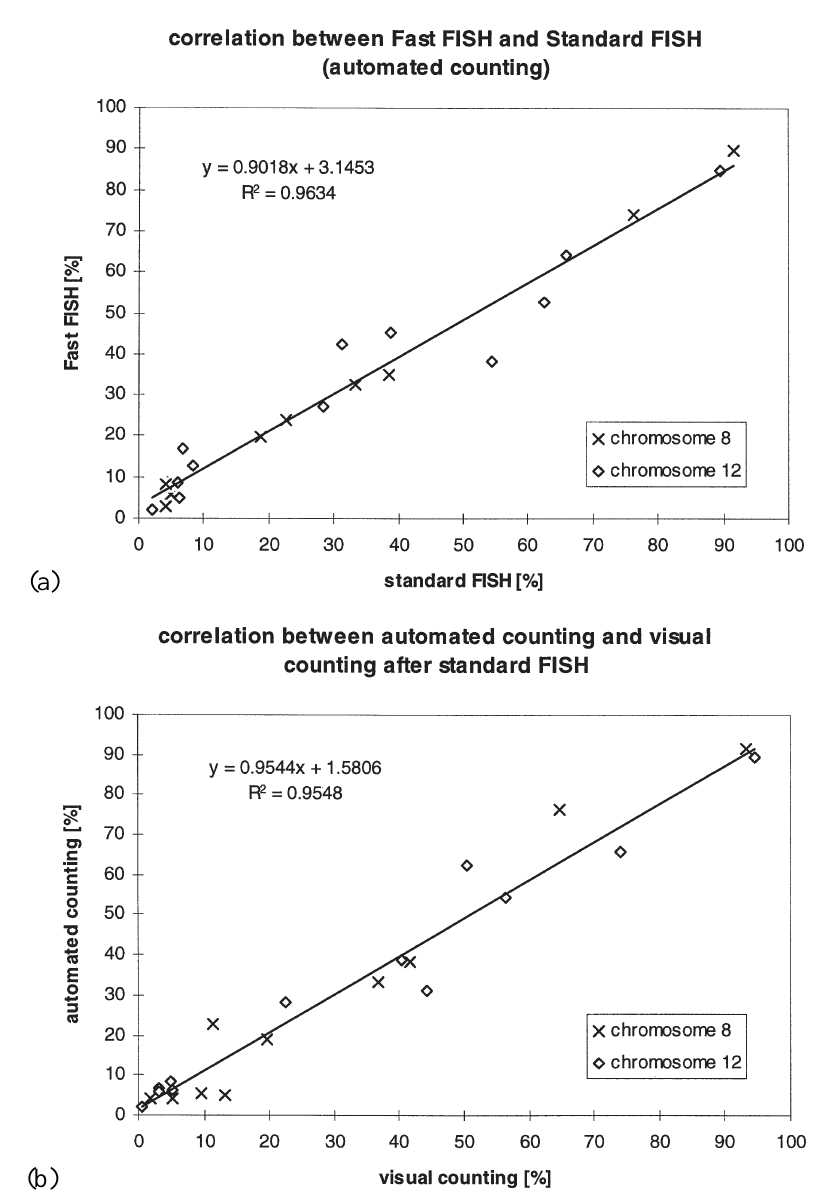
Fig. 4. Correlation of the percentage frequencies from Table 1. (a) Correlation of the values of column C to the values of column B. (b) Correlation of the values of column B to the values of column A. In both cases the automatically calculated fit curve ( y = ax + b ) is given with their confidence intervals R 2 ( = square of Pearson correlation coefficient). A χ 2 -test was applied. This revealed that the compared techniques give the same results on the 0.1% significance level (see Table